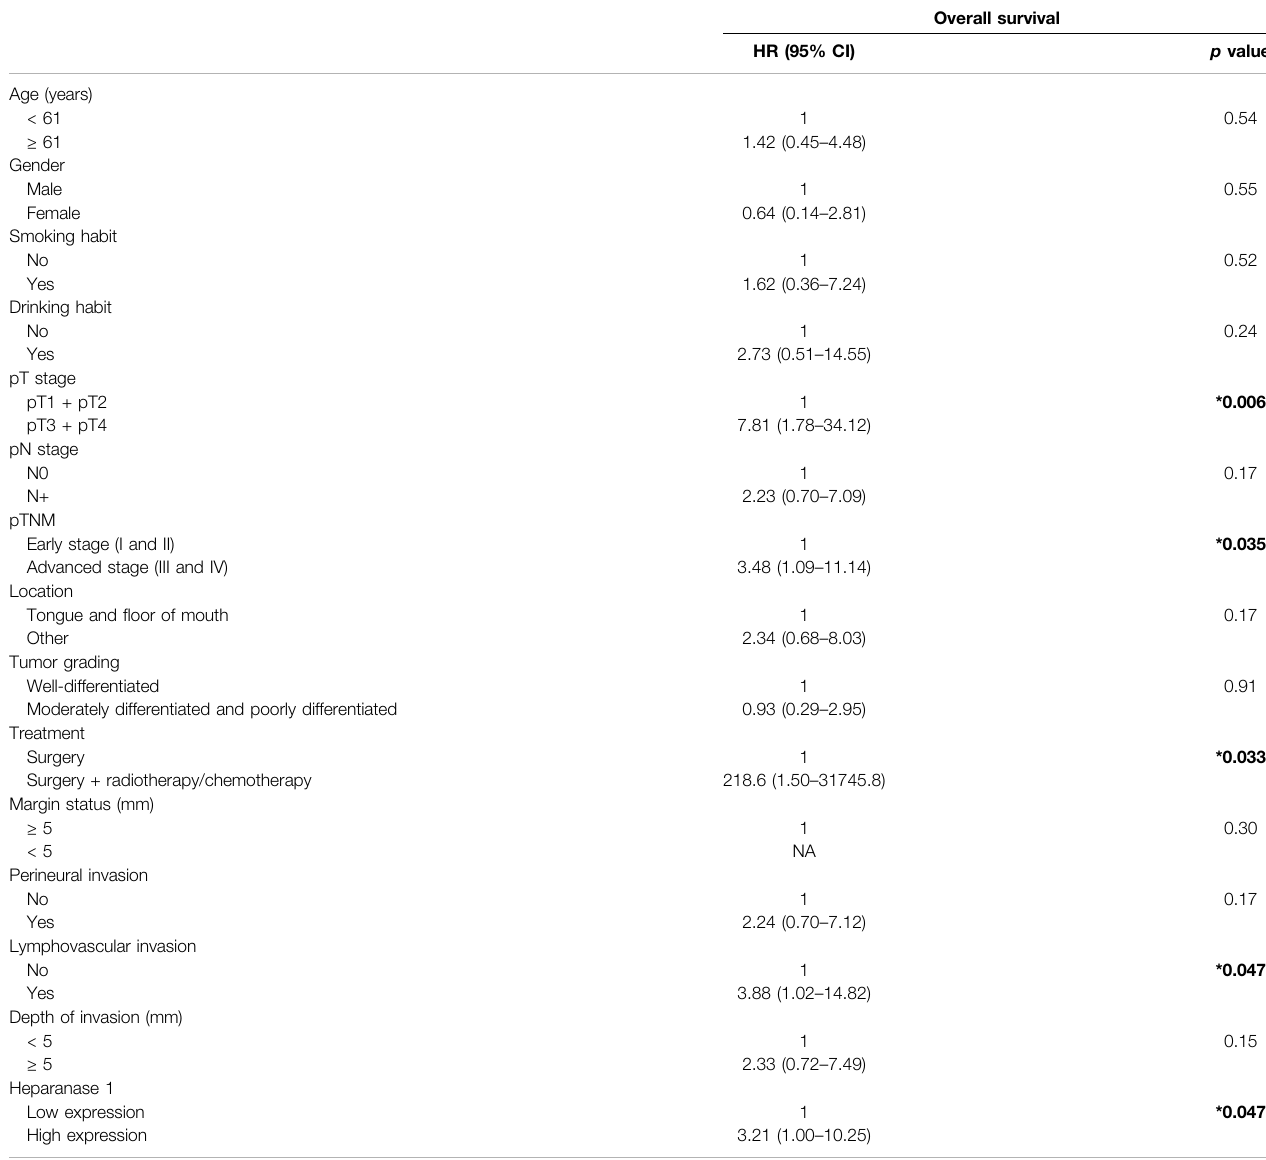
TABLE 2 | Univariate analysis for disease-speci fi c survival of patients with oral squamous cell carcinoma.